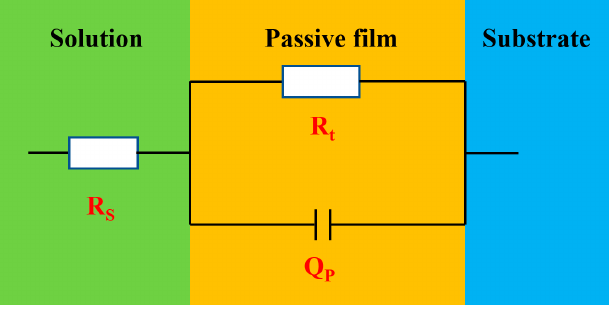
Figure 6. Equivalent circuits R s ( R t Q t ) used in the fitting procedure of the EIS experimental data. The corresponding fitting results are listed in Table 4. R s continuously increased with immersion time, it indicated that there was slight change for solution property in different immersion stage [24].